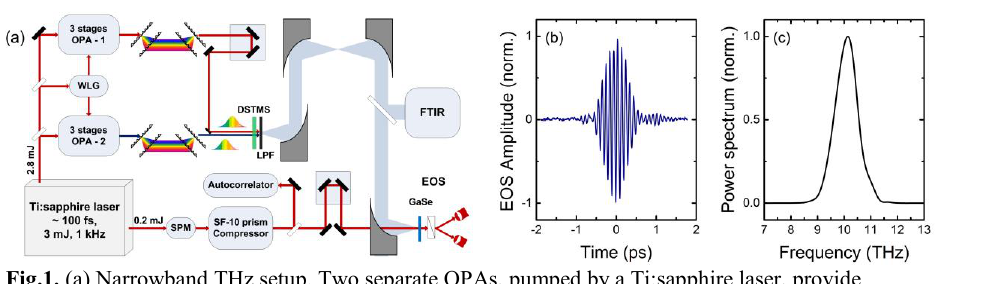
Fig.1. (a) Narrowband THz setup. Two separate OPAs, pumped by a Ti:sapphire laser, provide tunable signals which are linearly chirped afterwards for the DFG process in the DSTMS. The generated THz electric fields are characterized via FTIR or via electro-optic sampling in a GaSe (b) THz transient electric field generated by DFG in a 480µm thick DSTMS crystal as detected via electro-optic sampling in a GaSe crystal of 100 µm thickness. (c) Corresponding power